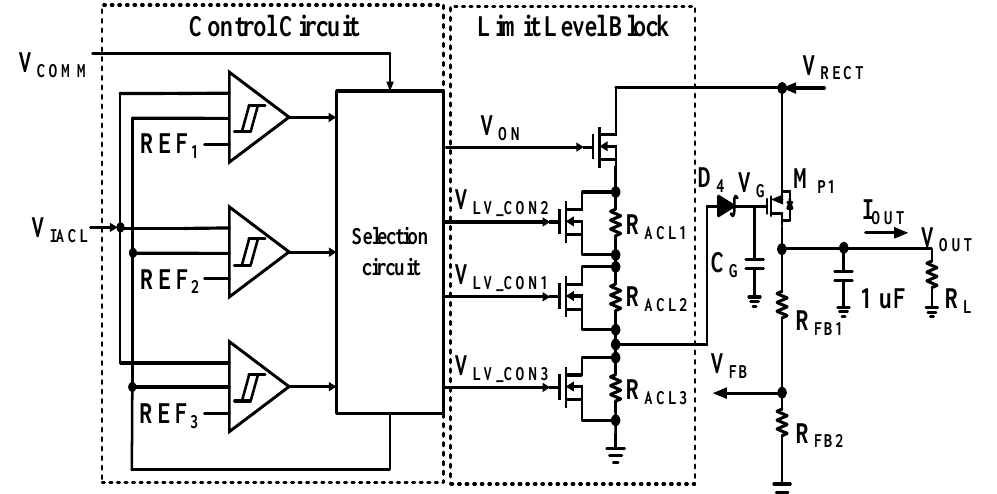
Figure 7. Adaptive communication limit circuit.